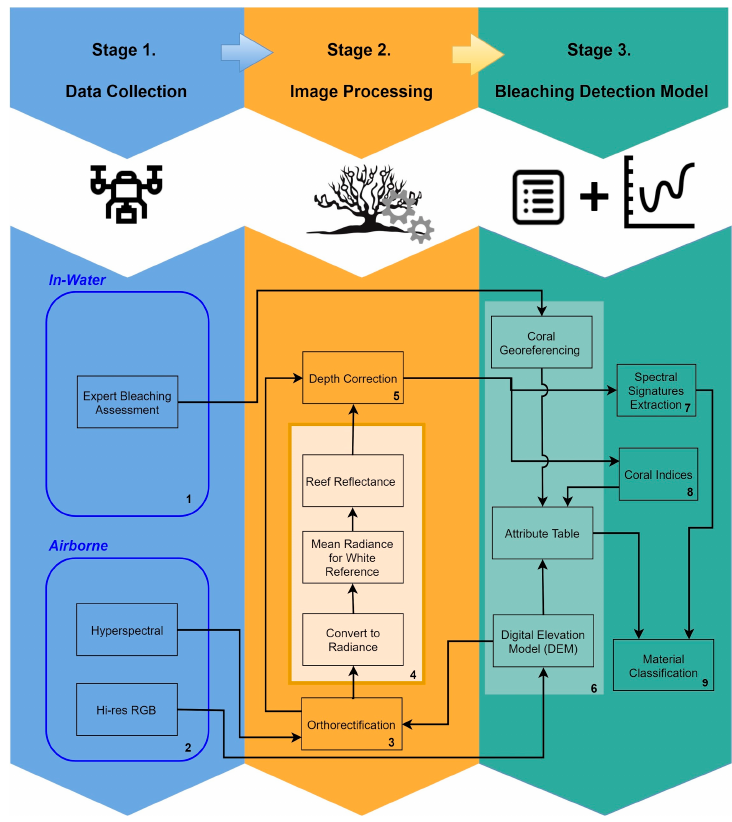
Figure 1. Predictive detection model workflow.